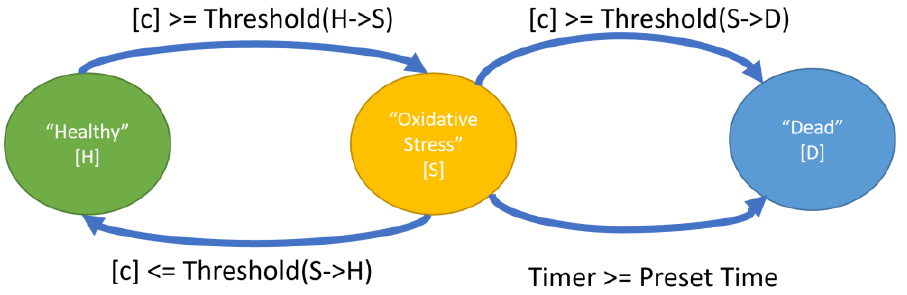
Figure 2. State-dependent ROS production and scavenging rates were assigned to individual voxels: Healthy (H), Oxidative Stress (S) or Dead (D). State changes were dynamic, based on either threshold conditions or triggered by the expiration of timers.